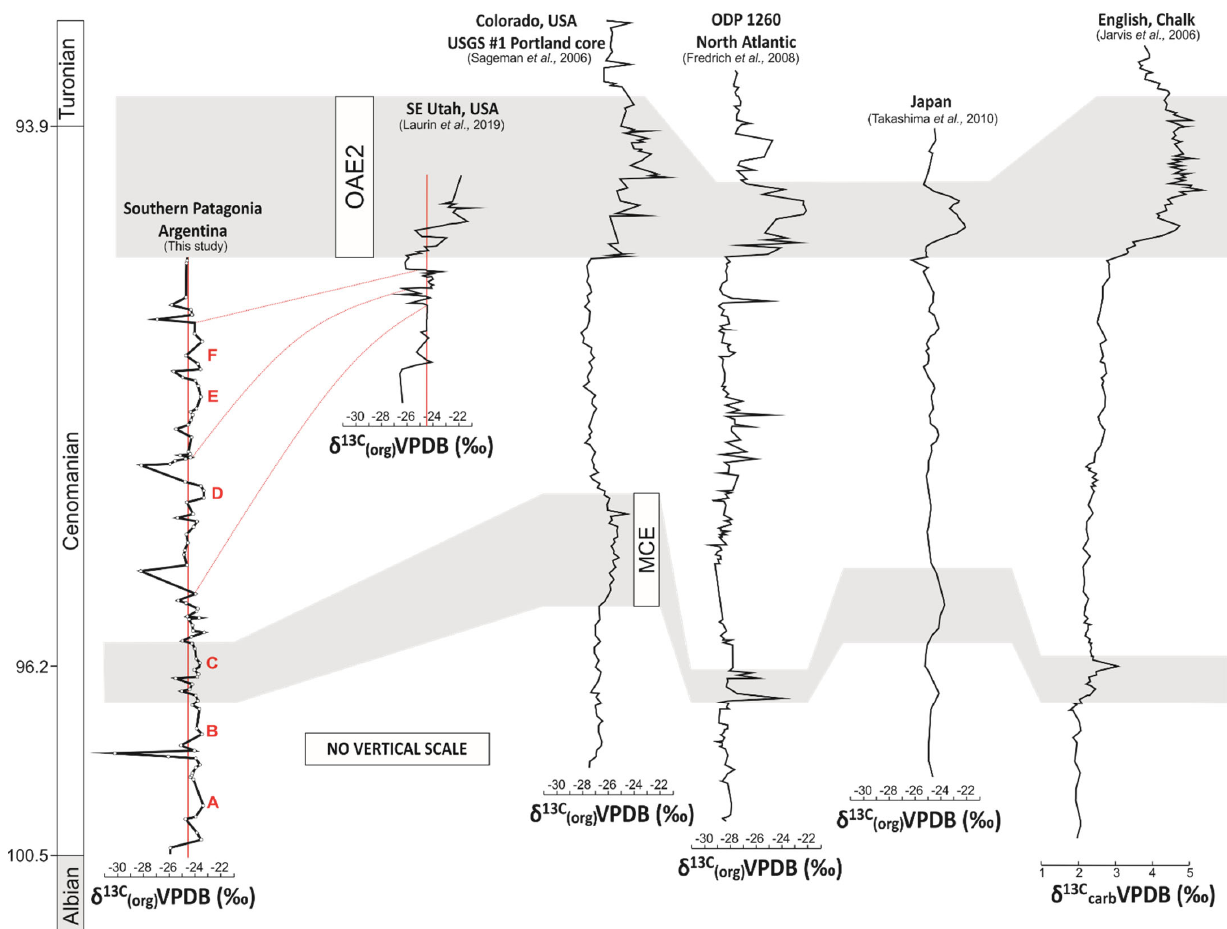
Figure 5. Chemostratigraphic comparison of the δ 13 C org trends from the Mata Amarilla Formation with global reference carbon isotope curves from SE Utah, USA (Laurin et al., 2019); Colorado, USA (USGS # 1 Portland core; Sageman et al., 2006); ODP 1260 North Atlantic (Friedrich et al., 2008); Japan (Takashima et al., 2010); UK (Jarvis et al., 2006). The positive carbon isotope anomaly of the Mid ‐ Cenomanian Event in Europe, North America and Asia is tentatively positioned in the Mata Amarilla Formation based on an U ‐ Pb age constraint of 96.23 ± 0.71 Ma. Red line represent potential correlation lines of similar δ 13 C org trends from the MAF and the terrestrial carbon isotope curve from SE Utah, USA (Laurin et al. 2019).